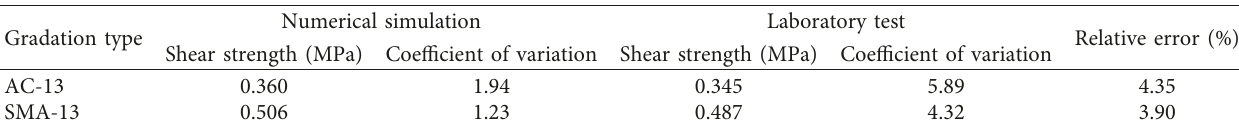
Figure 13: Displacement cloud image of two numerical model failure: (a) AC-13 and (b) SMA-13. Table 11: Comparison of numerical simulation results and laboratory test